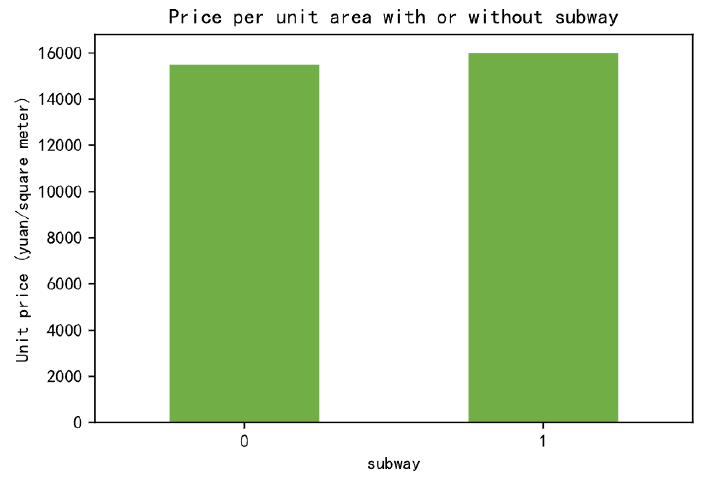
Fig. 10 The impact of proximity to the subway on housing prices